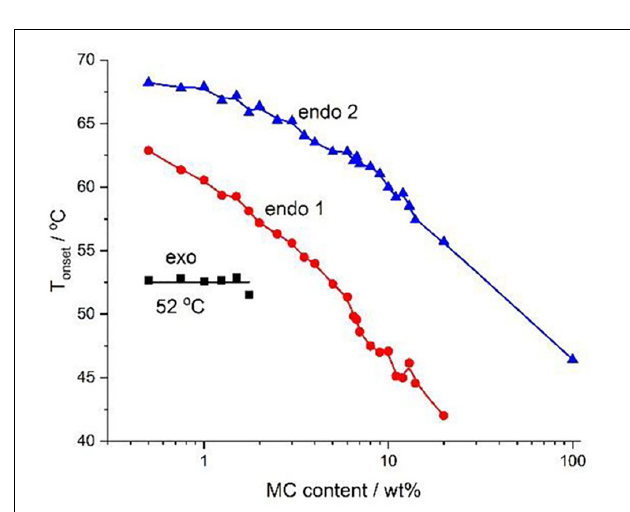
FIGURE 6 | The absolute value of the heat exchanged upon heating during the exothermic, the low-temperature (endo 1) and the high-temperature (endo 2) endothermic effects versus the MC content. Reproduced with permission from Niemczyk-Soczynska et al. (2019). Copyright 2019 Polymers.